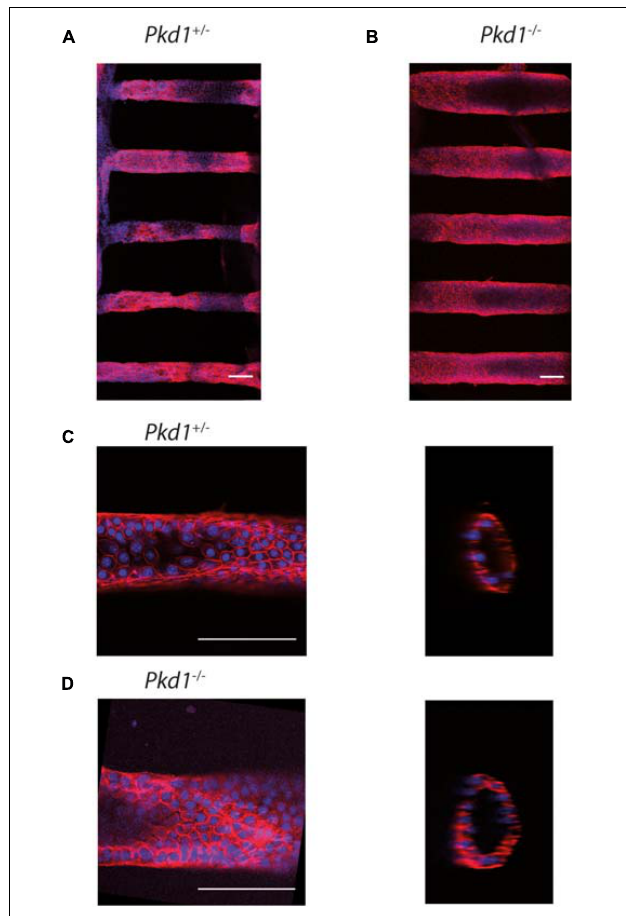
FIGURE 3 | PCT Pkd1 +/- and Pkd1 -/- organization in tubes. Cells were labeled for F-actin and nuclei, and imaged at confocal both at low and high resolution to study the global cell organization and F-actin organization. Confocal images of tubes labeled with phalloidin-TRITC (red) and Hoechst (blue). (A,B) global organization of Pkd1 +/- (A) and Pkd1 -/- (B) tubes imaged at a low resolution (10 × objective). Maximal z projections. Mean tube diameters of tubes in the chips shown, as assessed by z projection, were, respectively, ∼ 85 and 135 µ m for the chips shown in (A,B) , in agreement with Pkd1 -/- tube deformation. (C,D) Pkd1 +/- (C) and Pkd1 -/- (D) tubes imaged at a high resolution (40 × objective) in steps corresponding to the first early steps of tube dilation for Pkd1 -/- cells. Confocal section (left) and orthogonal projection (right). A median filter (3 pixels) was applied on orthogonal projection images. Scale bar, 100 µ m. Mean diameters measured for tubes imaged at high resolution were 85 ± 10 µ m for the Pkd1 +/- condition and 95 ± 5 µ m for the Pkd1 -/- condition for high resolution images (S.D. are indicated). Here 24 images of Pkd1 +/- tubes and 10 images of Pkd1 -/- tubes were done (performed, respectively, on 8 and 7 chips).